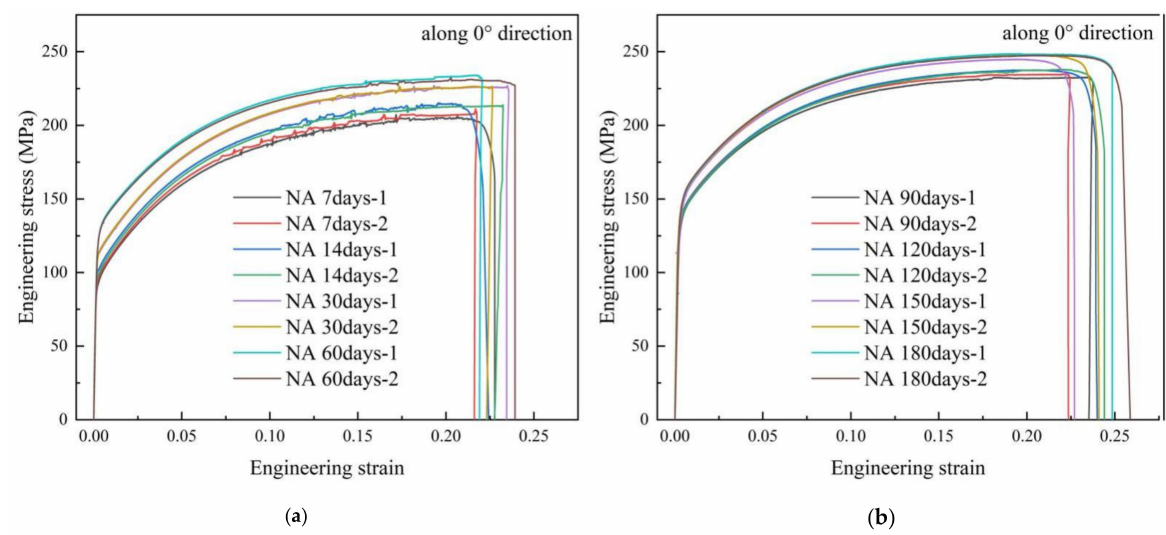
Figure 5. Engineering stress–strain curves along 0 ◦ direction at the different NA time: 7–60 days ( a ); 90–180 days ( b